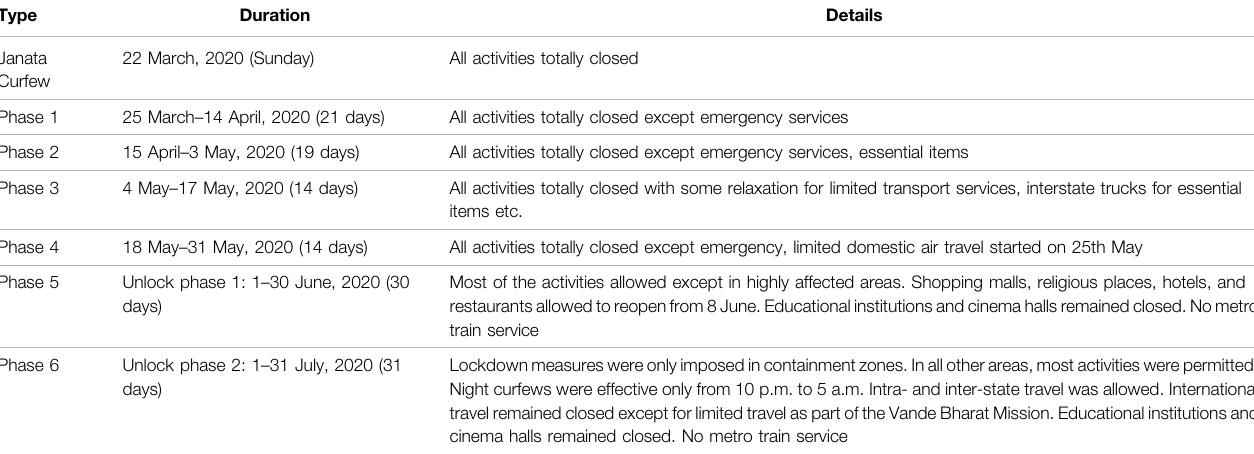
TABLE 1 | Various phases of lockdown in India to arrest the spread of the infection due to